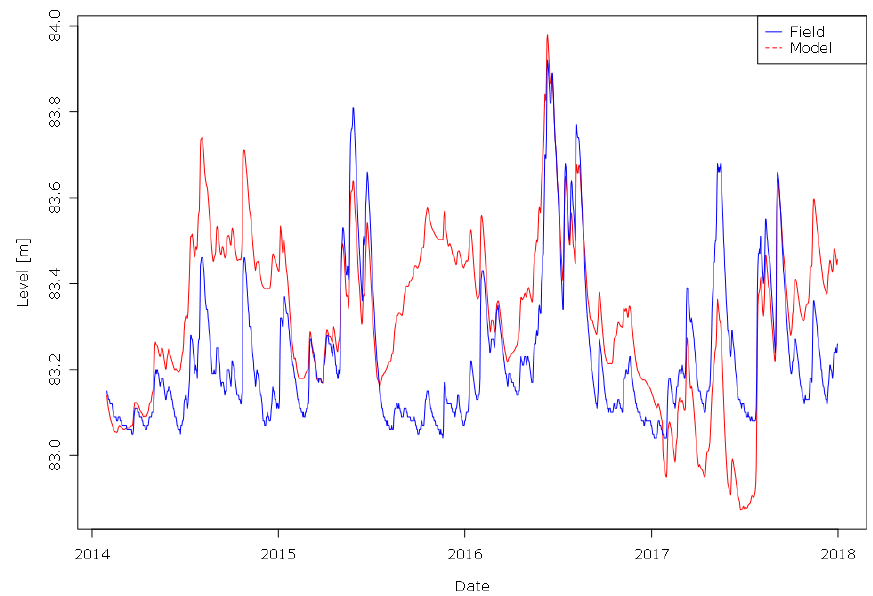
Figure 8. Observed (blue) and simulated (red) lake level of lake Ammersee.